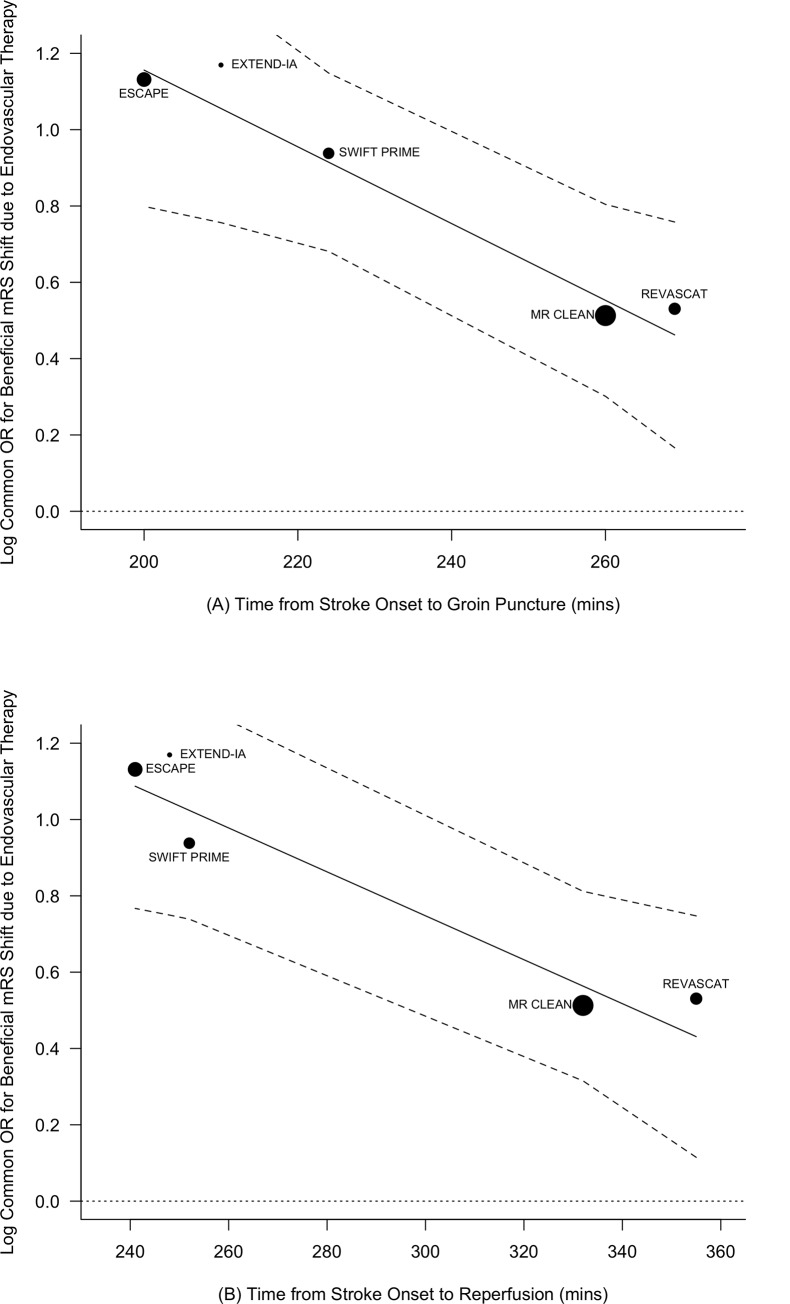
Meta-regression analysis relating trial effect estimates to workflow efficiencies.Mixed effects restricted maximum likelihood meta-regression models of log common odds ratios for improved functional outcome regressed against (A) median time from stroke onset to groin puncture and (B) median time from stroke onset to reperfusion, indicating that improved workflow efficiencies significantly influence the beneficial effects of endovascular treatment (P = 0.0077 and 0.0089, respectively).